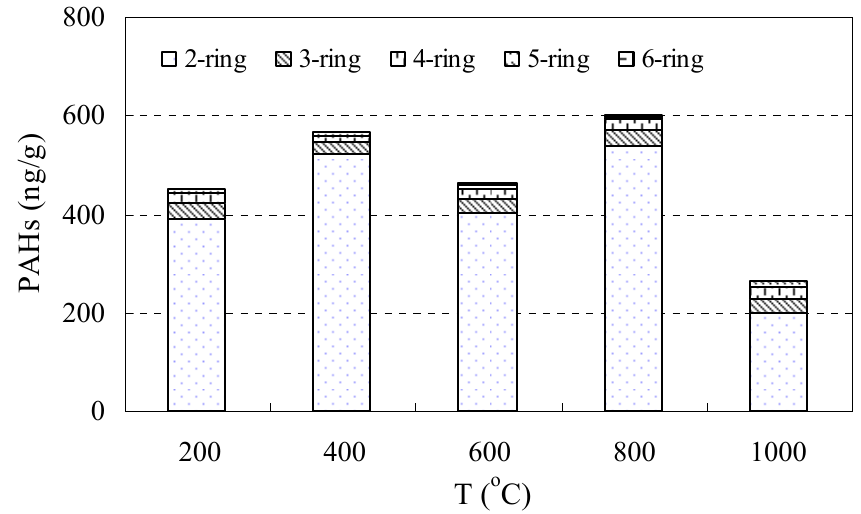
Figure 7. Release of PAHs in the oxygen-deficit heating test at different temperatures, according to ring number.